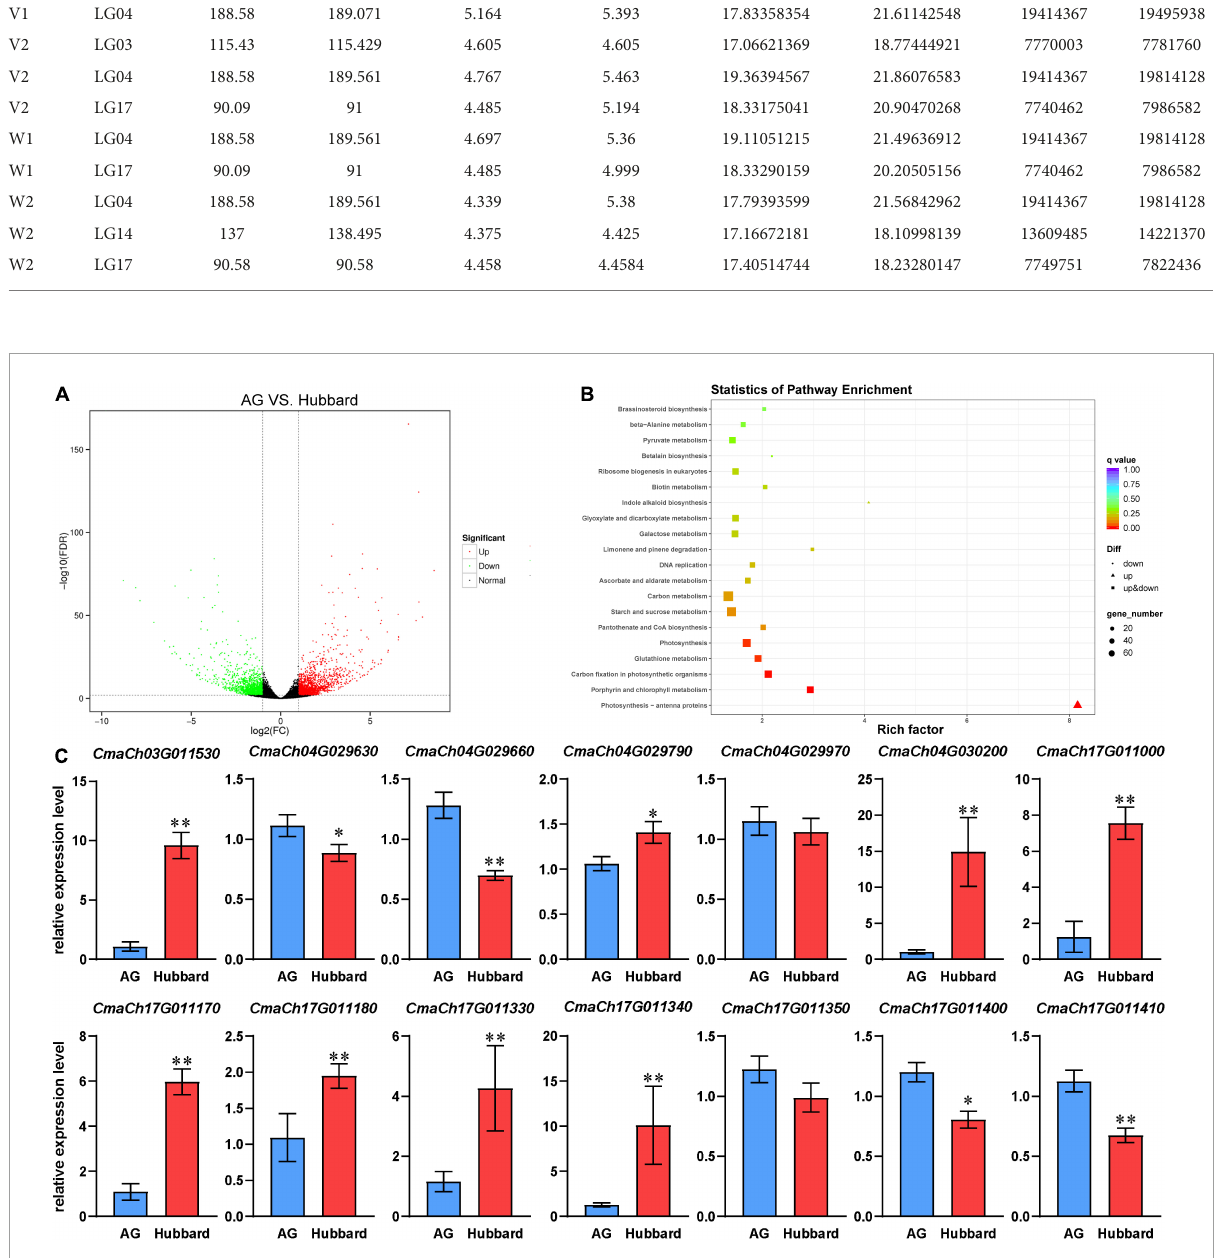
FIGURE4 Differentially expressed genes (DEGs) of fruits at 20 days after anthesis between Hubbard and Atlantic Giant. (A) Volcano Plot of DEGs. (B) Top 20 significantly enriched Kyoto Encyclopedia of Genes and Genomes (KEGG) pathways. (C) Fourteen DEGs located in quantitative trait loci (QTL) regions and also related to more than one traits between Atlantic Giant (AG) and Hubbard samples were verified by qRT-PCR. Date are presented as means ± SD ( n = 3, one-way ANOVA, *P < 0.05 , **P < 0.01